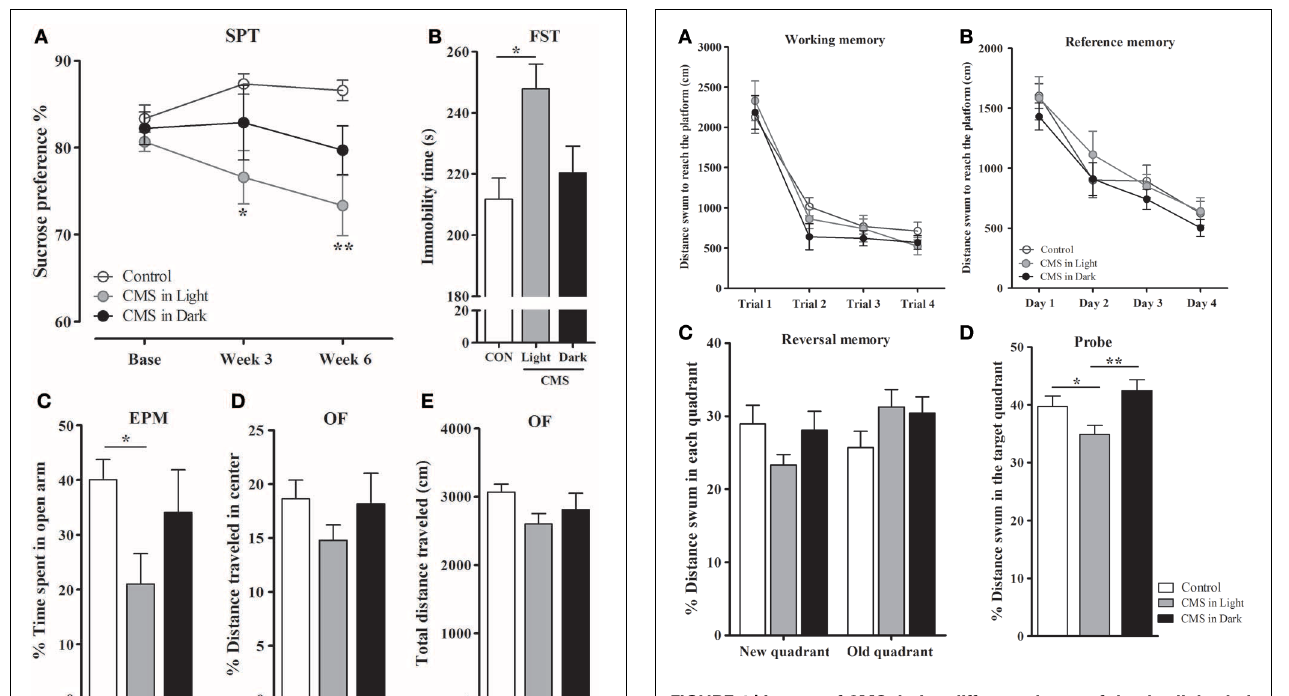
P = 0 . 01; CMS-Light/CON: P = 0 . 01; CMS-Dark/CON: 0.99;